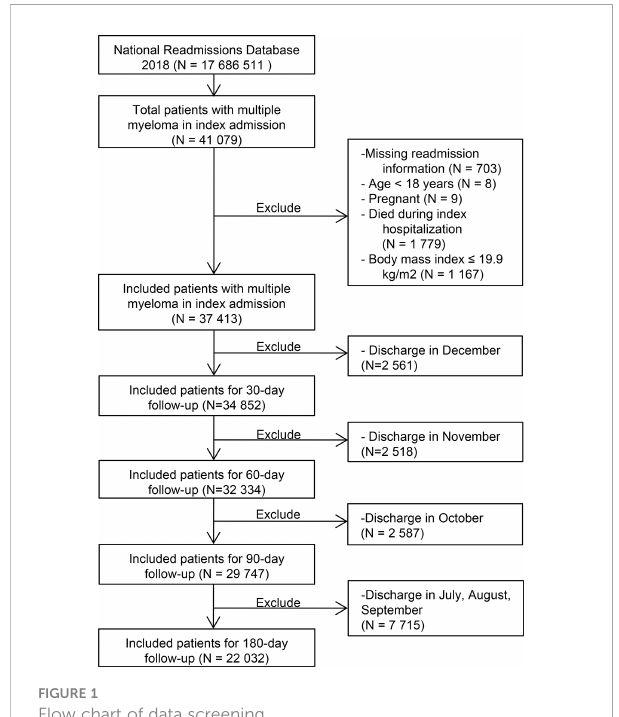
FIGURE 1 Flow chart of data